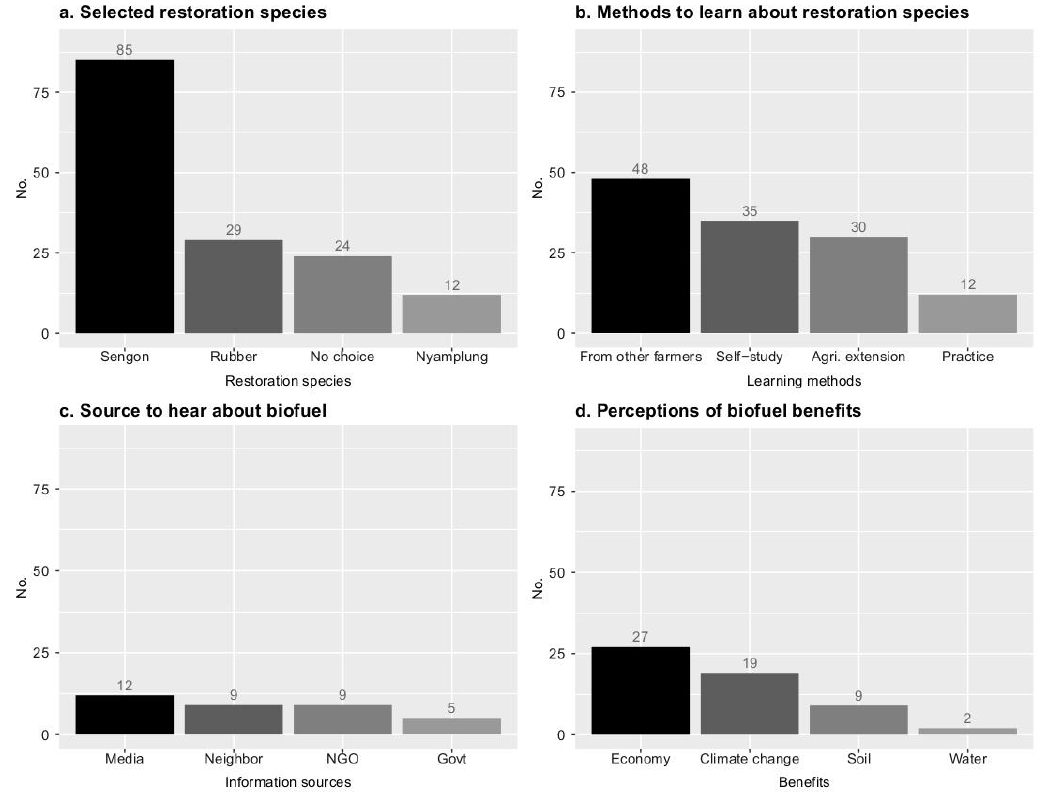
Figure 2. Landowner preferences for potential species for restoration of degraded land and their perceptions of bioenergy.